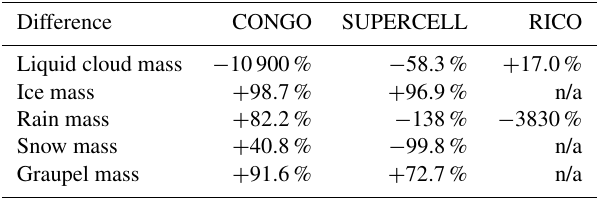
Table 3. Maximum relative difference of domain-mean hydrome- teor mass mixing ratio profiles for the MORR and THOM schemes. The relative change in the hydrometeor mass mixing ratios are com- puted in each case for M250 minus